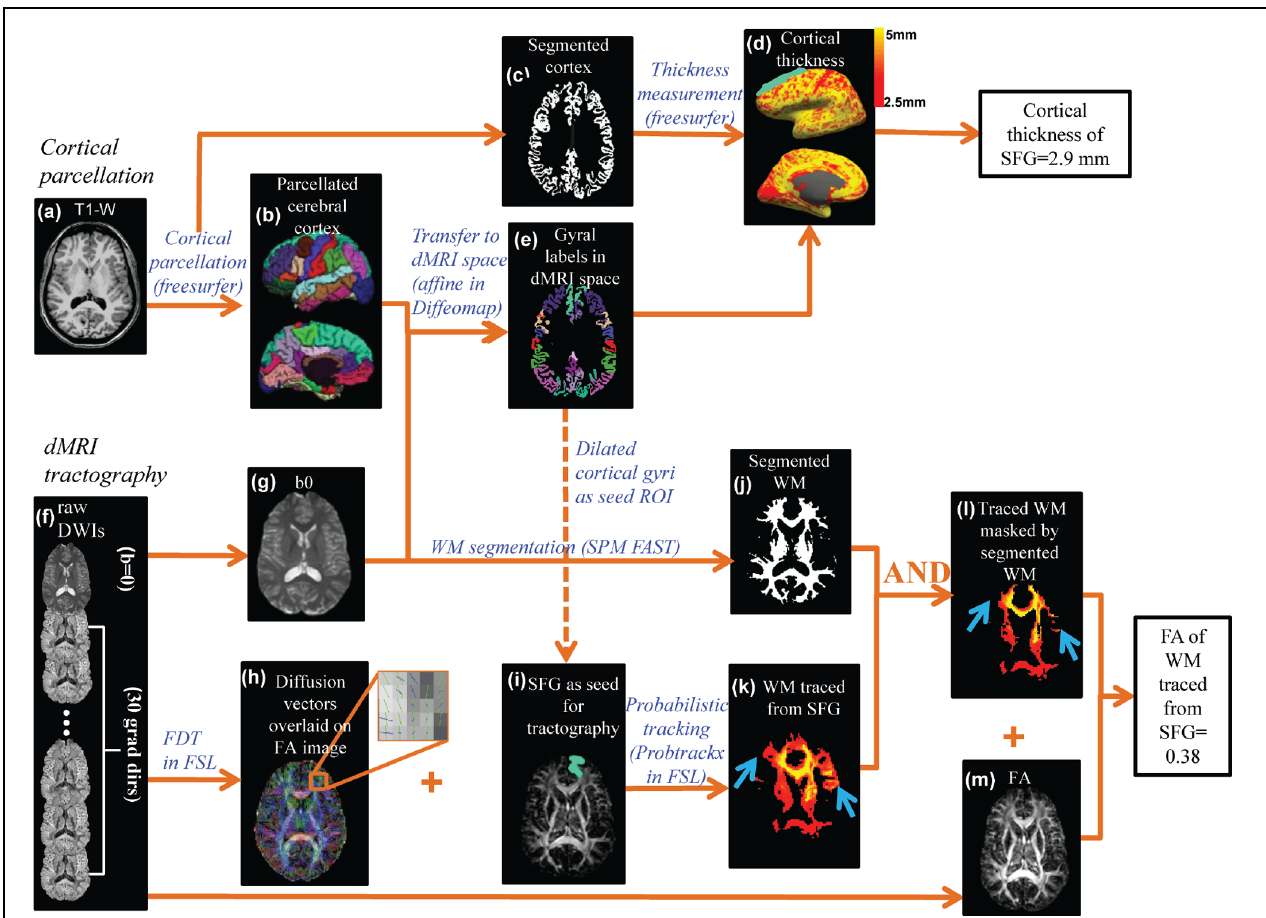
FIGURE 2 | The data analysis workflow of the cortical parcellation, Cortical thickness (CT) at different gyri and fractional anisotropy (FA) of white matter (WM) fibers traced from the same cortical gyri were measured by integrating information of T1-weighted image (a) and diffusion MRI (dMRI) (f). Based on the T1-weighted image (a) , the gray matter was segmented (c) and CT (d) of a specific cortical gyrus (e.g., superior frontal gyrus or SFG) was measured using the FreeSurfer software suite. The cortical surface was parcellated using FreeSurfer gyral labeling (b) which was transformed to dMRI space using linear affine transformation (e) with the b0 of dMRI as the transformation target (g) . Probabilistic tracing was implemented using Probtrackx in FSL. An enlarged view (h) of crossing fiber bundles in the superior frontal region showed crossed fibers could be delineated. A cortical gyral region of interest (ROI) after being dilated by five voxels (i) was chosen as a seed for probabilistic fiber tracing (k) . WM segmentation (j) obtained from FAST segmentation of the b0 image was used to retain only WM and exclude the traced regions entering the gray matter or cerebrospinal fluid (l) . The blue arrows in (k) and (l) point to the region where non-WM voxels were removed from the traced WM. Combined with the FA map (m) , FA of traced and filtered WM was then